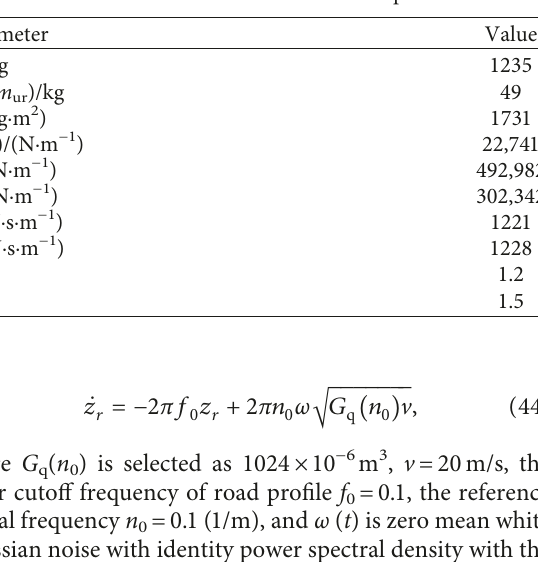
Figure 2: Control block of the designed hybrid fault-tolerant controller. Table 1: Parameters of half-vehicle